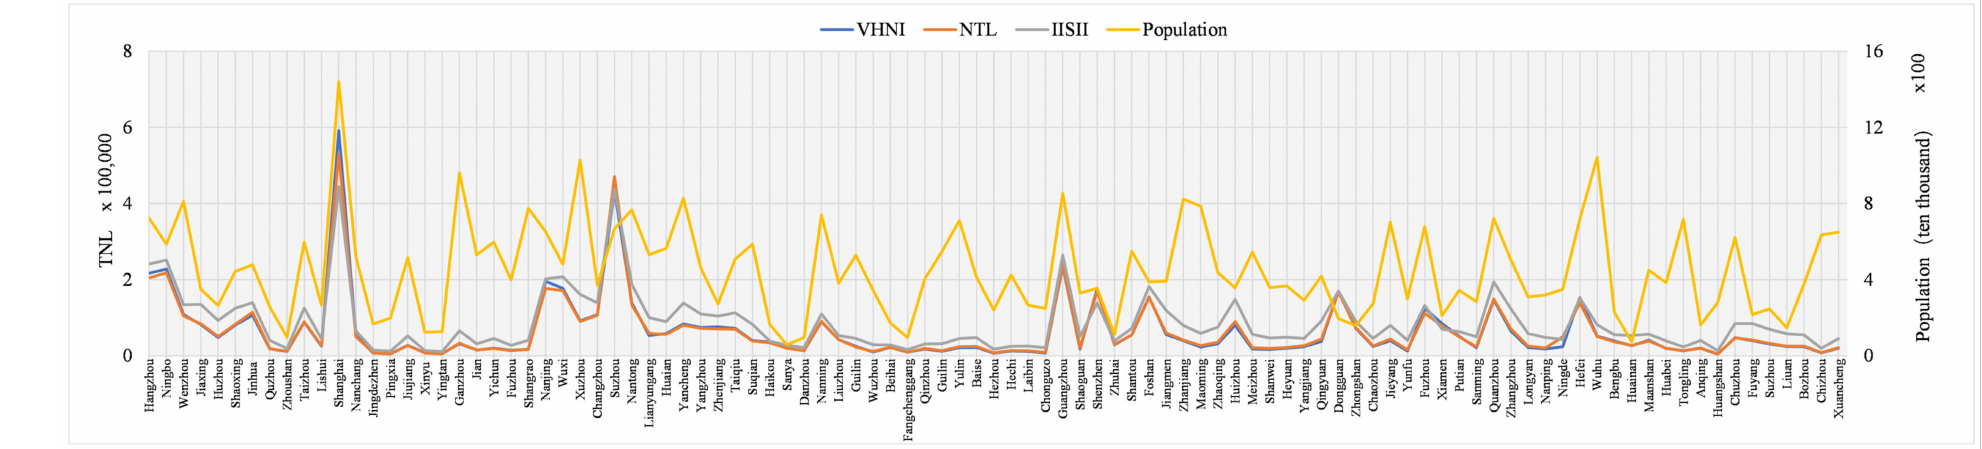
Figure 5. TNL of different indices and population at municipal